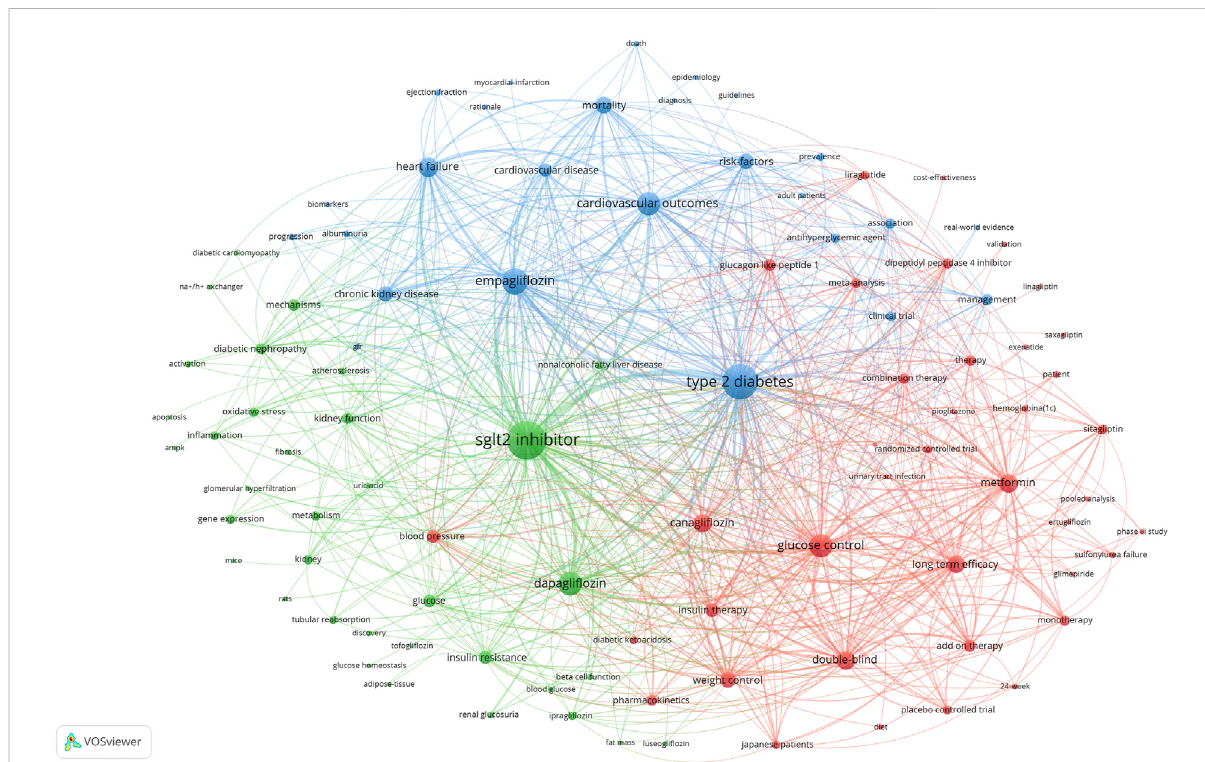
FIGURE 7 Co-occurrence network visualization map of the top 100 keywords. The visualization map of publications for 100 keywords forming three collaborating clusters (nodes with the same color); a node represents a keyword, the size of the node represents the number of publications, a link shows collaboration, and the distance and the thickness of the link between nodes show the relative strength of the